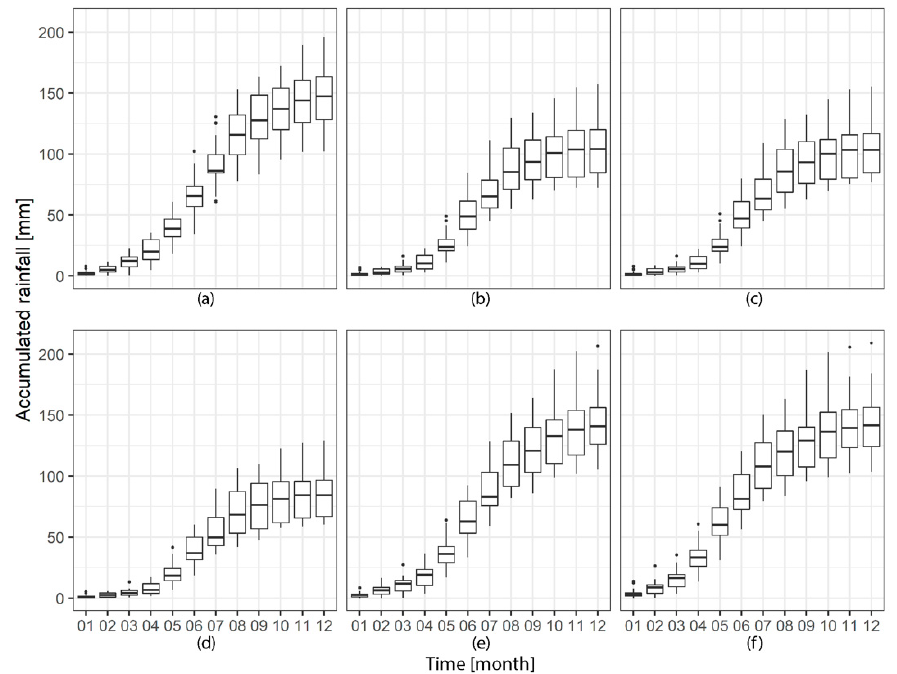
Figure A1. Box-plot of accumulated rainfall per month for the agro-climatics areas of Biobio: ( a ) Secano Costero, ( b ) Secano interior, ( c ) Depresión Intermedia, ( d ) Cordón Isla, ( e ) Precordillera and ( f ) Cordillera.